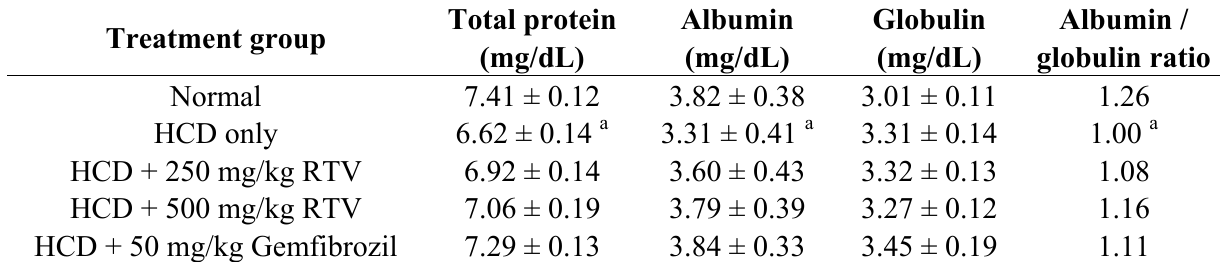
Table 1. Effects of crude extract of rhizomes of T. violacea on total protein, albumin, and globulin protein of rats kept on a high-fat